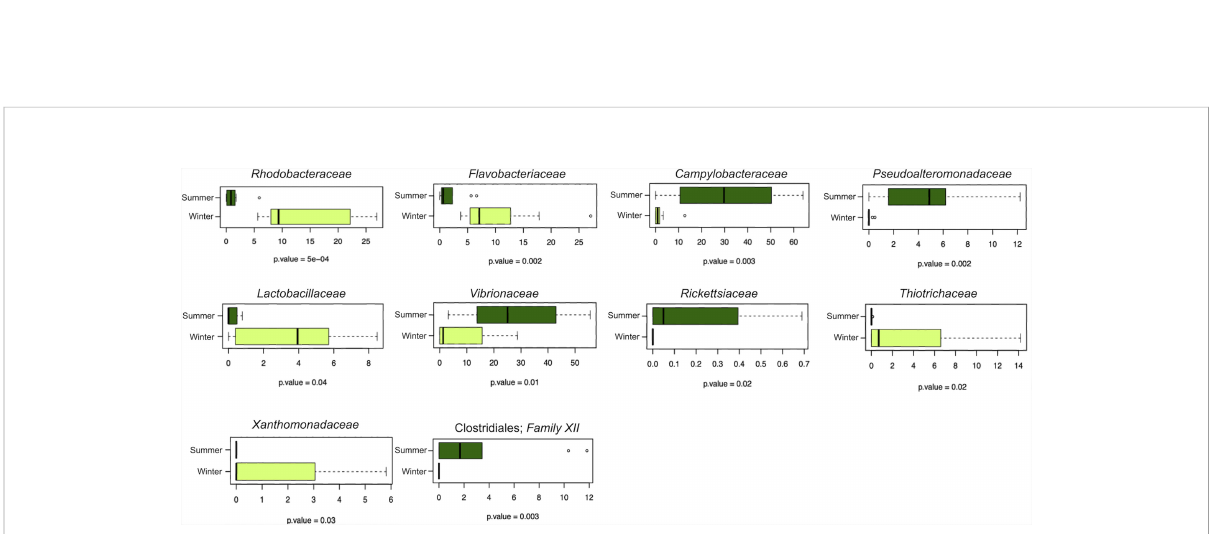
FIGURE 3 Microbial families responsible for signi fi cant compositional differences between the A. viridis microbiota in winter and summer samples collected at the Riccione site. Box-and-whisker plots showing the relative abundance of bacterial families whose differential distribution was signi fi cantly different in the A. viridis microbiota in winter ( “ darkolivegreen1 ” ) and summer ( “ darkgreen ” ) samples according to MaAsLin2 (Multivariate Association with Linear Models 2, Version 1.8.0). The central box represents the distance between the 25th and 75th percentiles. The median is marked with a black line. Whiskers identify the 10th and 90th percentiles. P-values are reported below each box plot (Wilcoxon rank-sum test controlled for multiple testing using FDR).